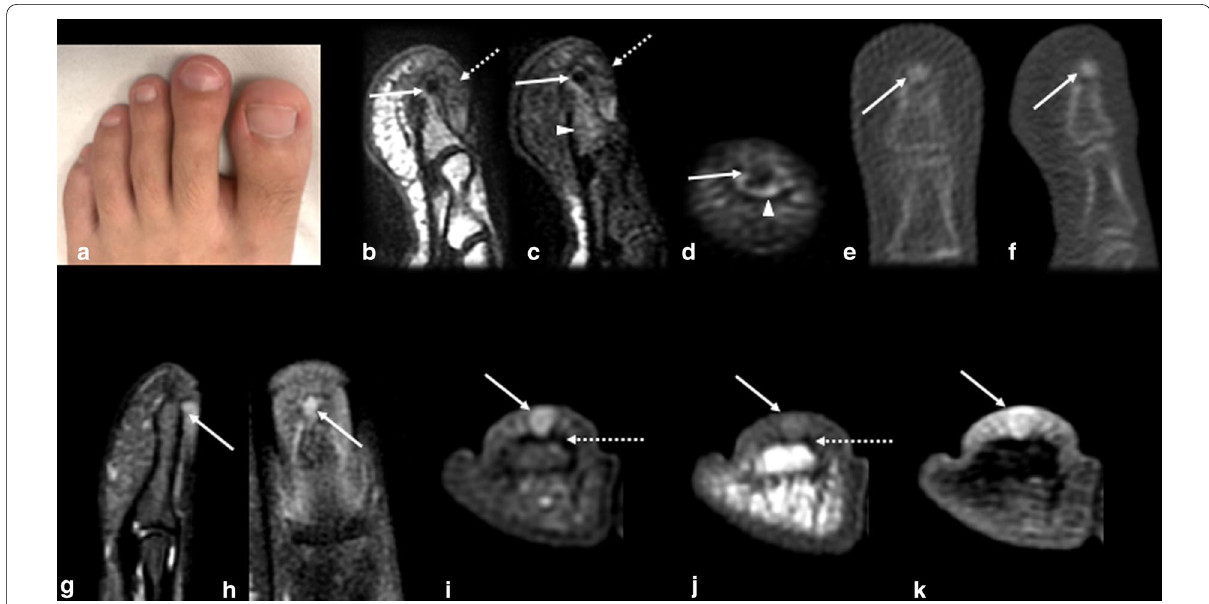
Fig. 14 Osteoid osteoma versus glomus tumor. ( a – f ) Male, 19 years old, presenting with second toe clubbing and night pain ( a ). Sagittal T1 ( b ) and sagittal ( c ) and axial ( d ) T2FS MR images showed diffuse nail bed thickening (dotted arrows), with no defined nodule, as well as a low signal cortical/ juxtacortical nodule at the distal phalanx (arrows), accompanied by bone marrow edema (arrowhead). A CT scan ( e , f ) was performed, and the findings revealed a sclerotic nodule corresponding to an OO nidus (arrows), with minimal reactional surrounding sclerosis. ( g – k ) Female, 53 years old, presenting with pain on the 4th finger that radiated to the forearm. Sagittal, coronal, axial T2 FS, axial T1 and T1 FS GD MR images depicted a subungual nodular well-defined lesion (arrow) with remodeling of the subjacent phalanx cortex (dotted arrow) and homogeneous enhancement after gadolinium injection ( k ). Note that diffuse thickening of the nail bed or phalanx sclerosis was